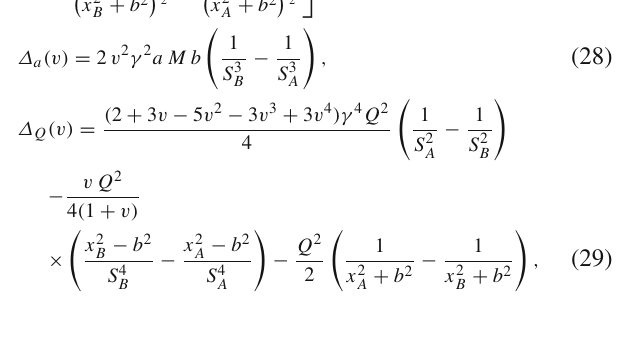
Fig. 2 Δ M 2 (v), Δ a (v) , and Δ (v) plotted as the functions Q of the radial velocity v of the lens respectively in linear scale (left column). For the convenience of display of the nonrelativistic cases, we also show | Δ M 2 (v) | , | Δ a (v) | , and | Δ (v) | vs v respectively in Q log-log scale (right column), with a sample domain [ 1 . 0 × 10 − 8 , 0 . 99 ] for v . As an example, we set { x , x } = {− 10 b , 5 b } A B (red), {− 1 . 0 × 10 5 b , 10 b } (thin blue), {− 10 b , 1 . 0 × 10 5 b } (dotted green), and {− 1 . 0 × 10 5 b , 2 . 0 × 10 5 b } (dot-dashed purple) for four different scenarios. Here, b = 1 . 0 × 10 5 M , a = 0 . 1 M , and Q = 0 . 01 M are